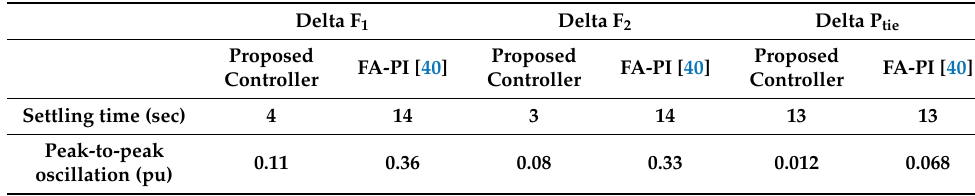
Table 7. Dynamic performance indices of case